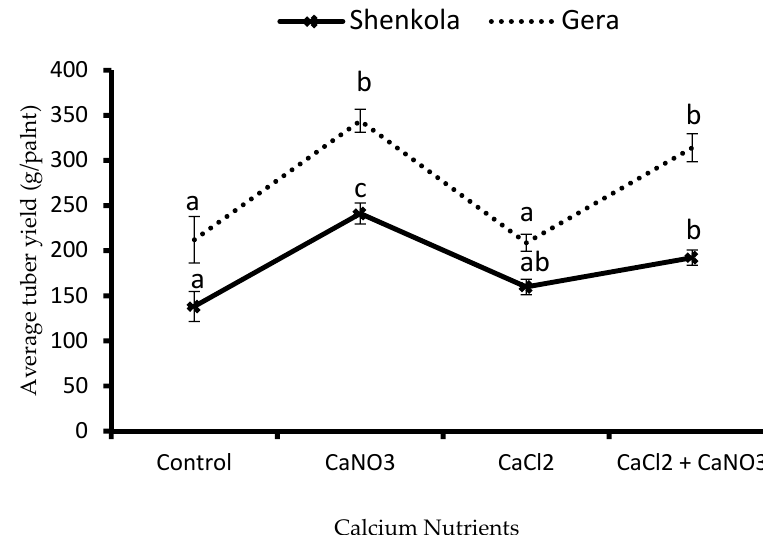
Figure 2. Average tuber yield of two potato varieties (Shenkola and Gera) for potato plants grown without calcium nutrient supply (control) and potato plants supplied with CaNO 3 alone, CaCl 2 alone, and CaNO 3 mixed with CaCl 2 . Error bar represents ± SE from n = 4 for control plants and n = 12 for potato plants supplied with calcium nutrients. Different letters indicate significant difference between calcium nutrients ( p < 0.05).